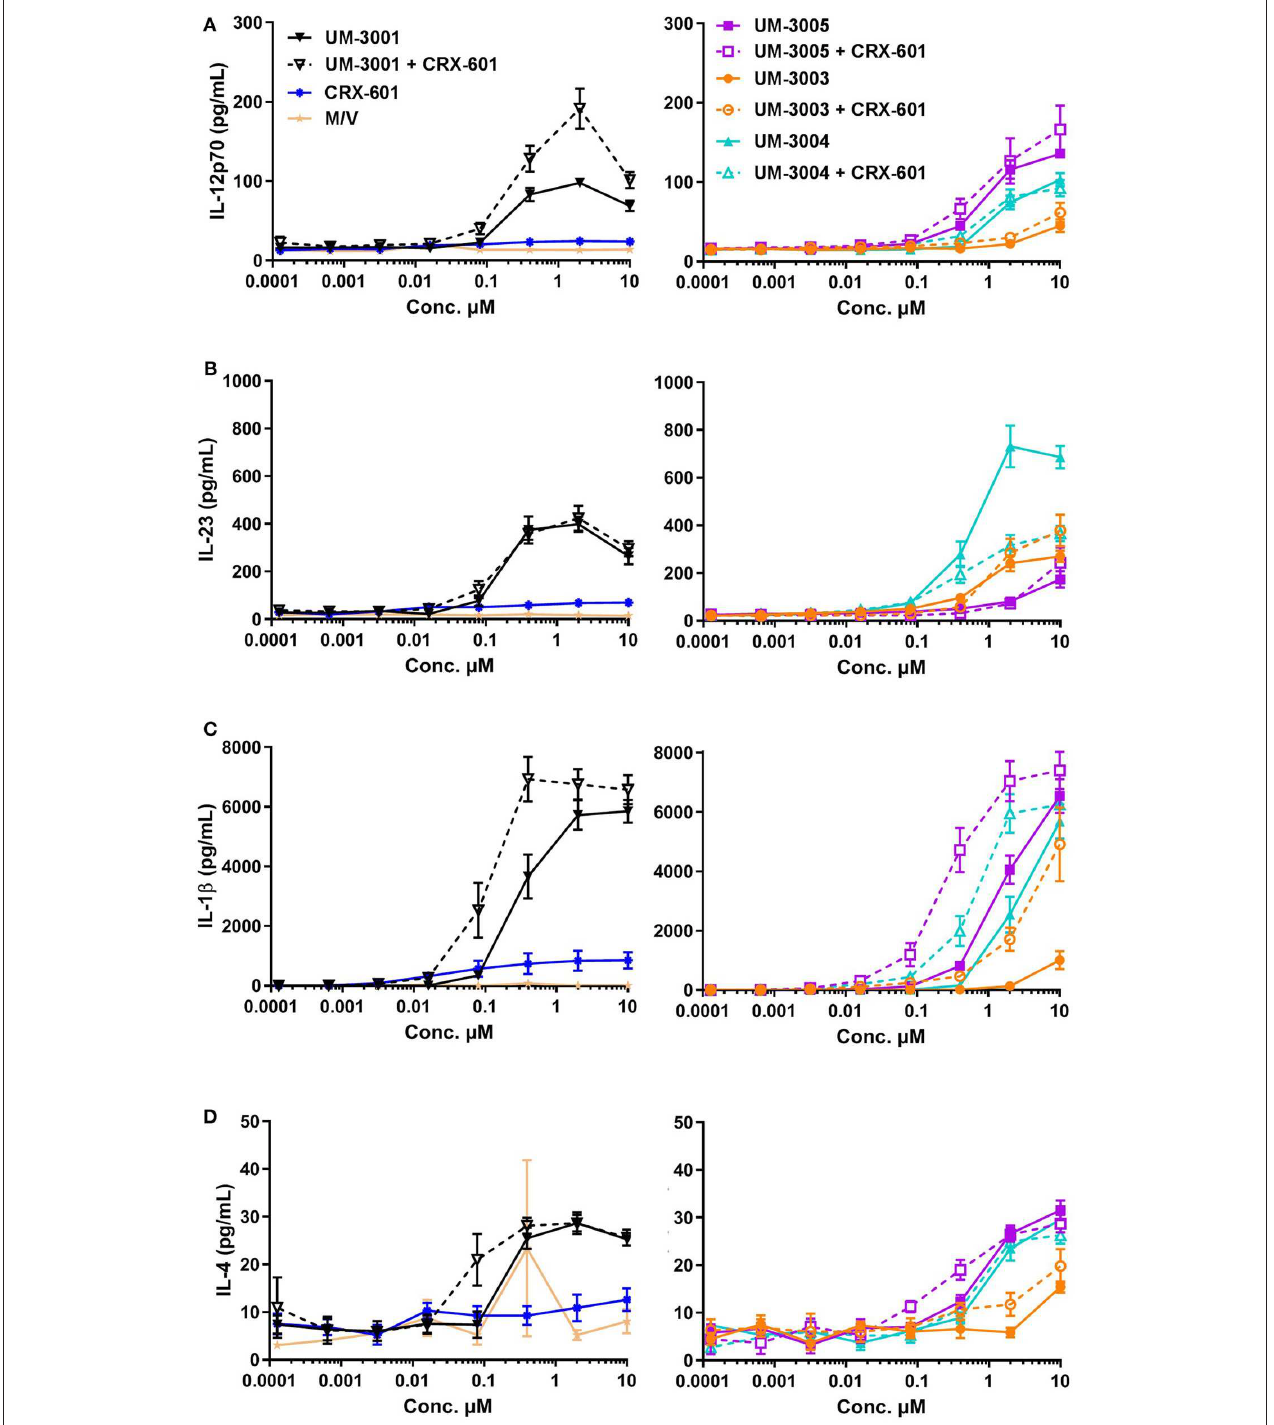
FIGURE 6 | Lipidated imidazoquinolines elicit a Th1/Th17-inducing innate cytokine profile from human PBMCs. PBMCs from 6 healthy, adult blood donors were stimulated with indicated concentrations of TLR7/8 agonists with and without a TLR4 agonist. Secreted cytokines were measured after 24h via Luminex assay. Supernanant concentrations of (A) IL-12p70, (B) IL-23, (C) IL-1 β , and (D) IL-4 were determined. For clarity, cytokine secretion data from PBMCs stimulated with media only (M/V), CRX-601, non-lipidated TLR7/8 agonist UM-3001, and UM-3001 + CRX-601 are displayed in left plots while cytokine secretion data from PBMCs stimulated with lipidated TLR7/8 agonists alone and in combination with CRX-601 are diplayed on right plots. Note that for each cytokine measured, the y-axis scale used for the left and right plots is identical for ease of comparison.